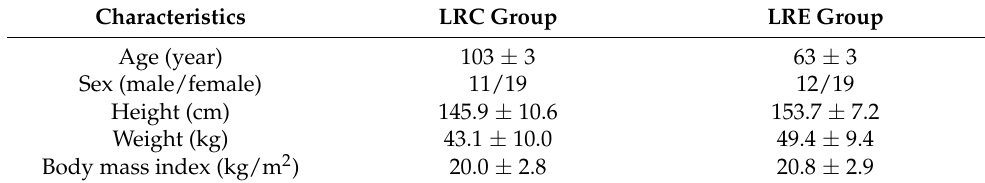
Table 1. Characteristics of the